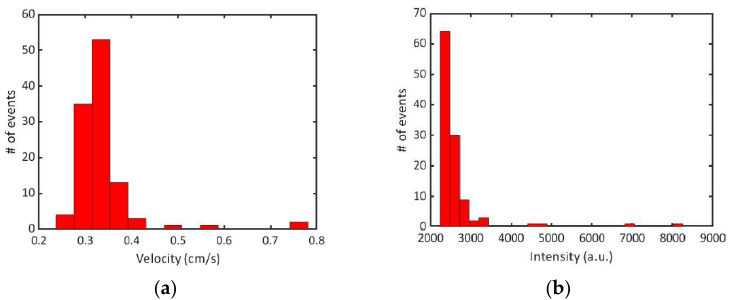
Figure 7. ( a ) Velocity distribution of detected events. Average velocity is 0.34 cm/s with a standard deviation of 0.07 cm/s. ( b ) Intensity distribution of detected events. Average intensity is 2055 with a standard deviation of